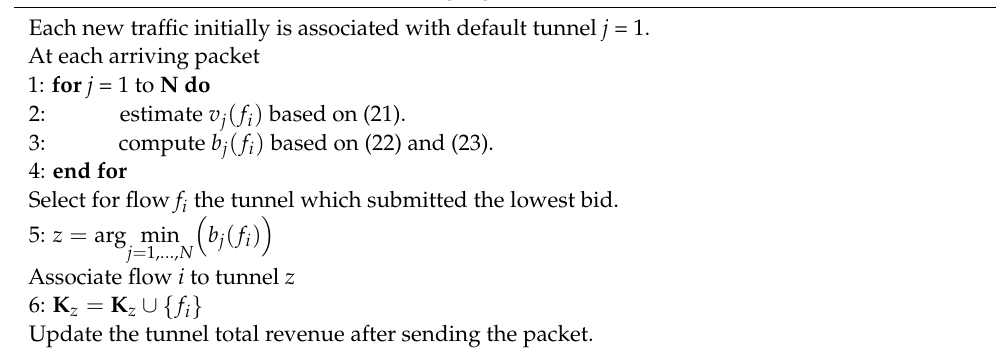
Algorithm 2 Auction-based load-balancing